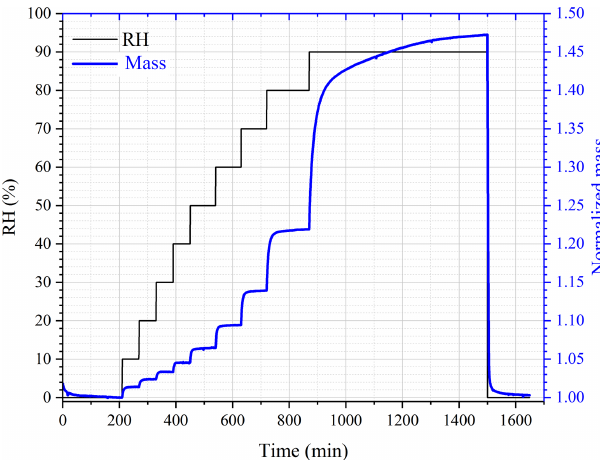
Figure 1. Change in RH (black curve, left y axis) and normalized sample mass (blue curve, right y axis) with time for a typical exper- iment in which hygroscopic growth of pollen grains was measured. In this figure a data set for paper mulberry pollen at 25 ◦ C is plotted as an